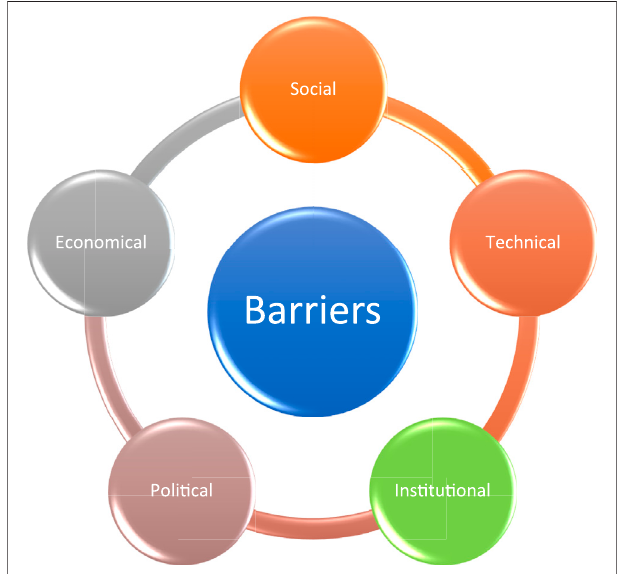
FIGURE 10 | Barriers lead to energy